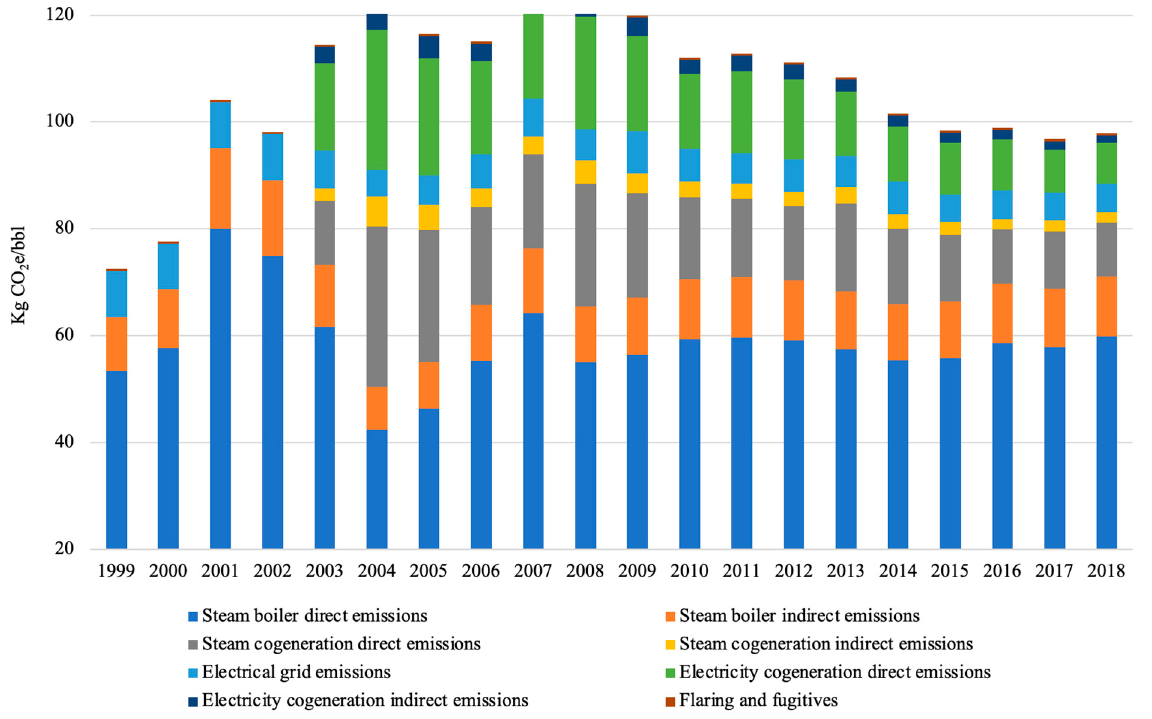
Figure 3. Case 2—GHG emissions intensity of SAGD operations per year (with total electricity produced and no electricity credit).